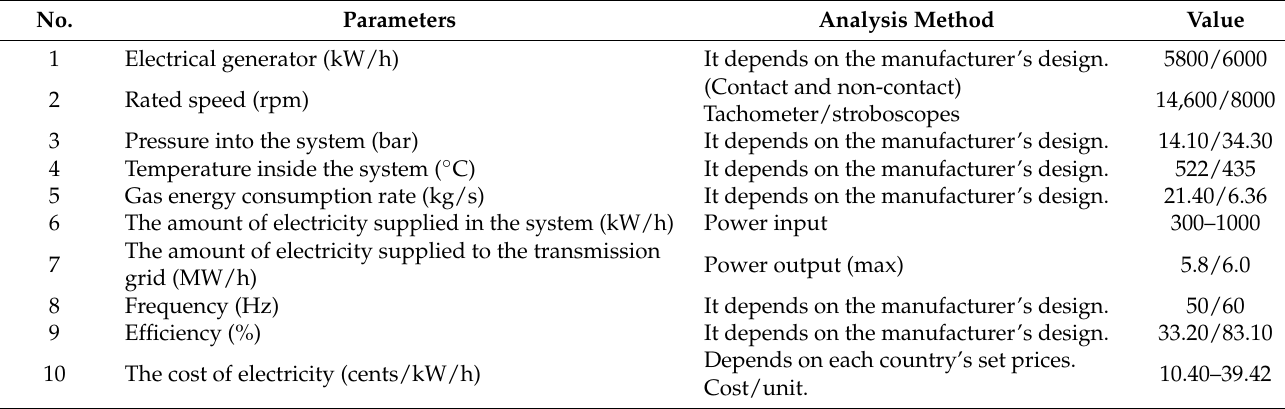
Table 3. Data used in the analysis of the features and methods of machines from 2 manufacturers for 5.8 (MW/h) product model (SGT-A05 (KB7HE)) and 6 (MW/h) product model